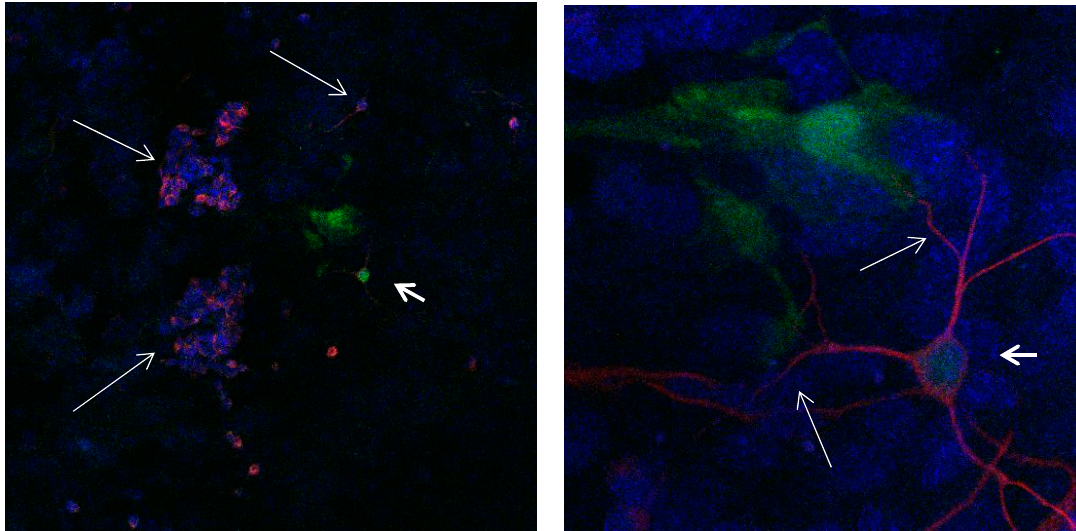
Figure 16. Cultures in a serum-containing medium, 5 days after the passage: Immunofluorescence with anti-ß-tubulin-III (red, secondary antibody: goat anti-mouse IgG Alexa Fluor 555), and with anti-Calbindin D28k (polyclonal antibody from the company SWANT) (green, secondary antibody: donkey anti-rabbit IgG Alexa Fluor 488); Nuclear staining with DAPI (4 ′ ,6-diamidino-2-phenylindole dihydrochloride) (blue). Confocal microscopy. Left : zoom = 1, numerous ß-tubulin-III-positive neurons (long arrows), on the right 1 Calbindin D28k positive and tubulin-III-positive neuron (short arrows). Right : zoom = 4, higher magnification of the Calbindin D28k positive and tubulin-III-positive neuron (short arrows) with extensions (long arrows). Above some Calbindin D28k positive astrocytes.